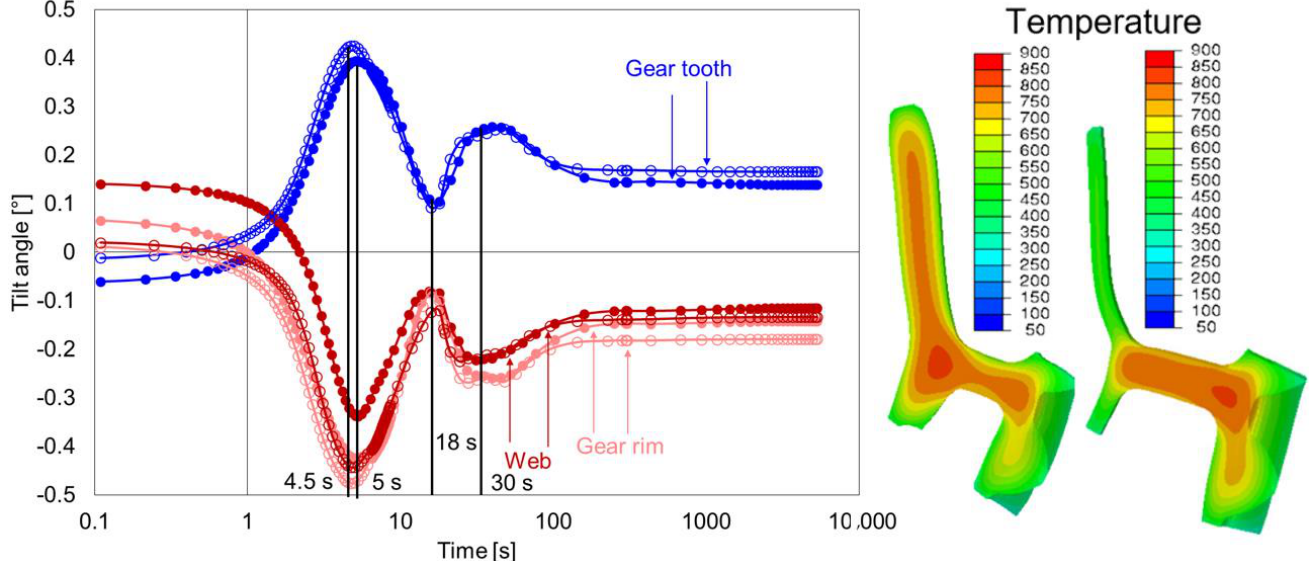
Figure 19. Tilt angle development of the web, gear rim, and gear tooth for the geometry type G4 (circle without fill) and Figure 18. Tilt angle development of web, gear rim, and gear tooth for the geometry type G3 (circle with fill) and comparison comparison with geometry type G2 (circle with fill) during quenching ( left ), and temperature distribution and contour with geometry type G5 (circle without fill) during quenching ( left ), and temperature distribution and contour plot for G3 plot for G2 and G4 after 4 s ( right ). and G5 after 5 s ( right